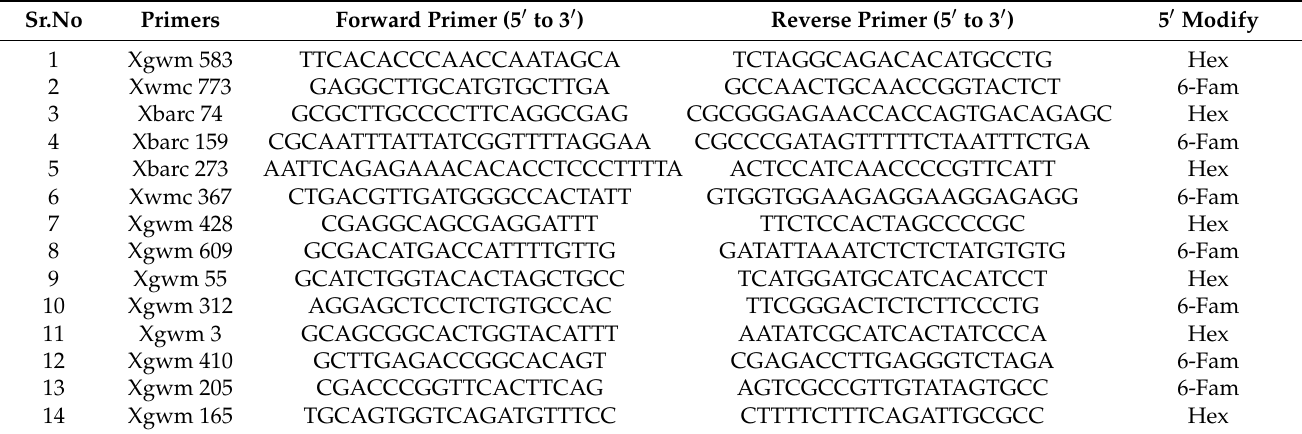
Table 5. Sequence of 14 simple sequence repeats (SSR)